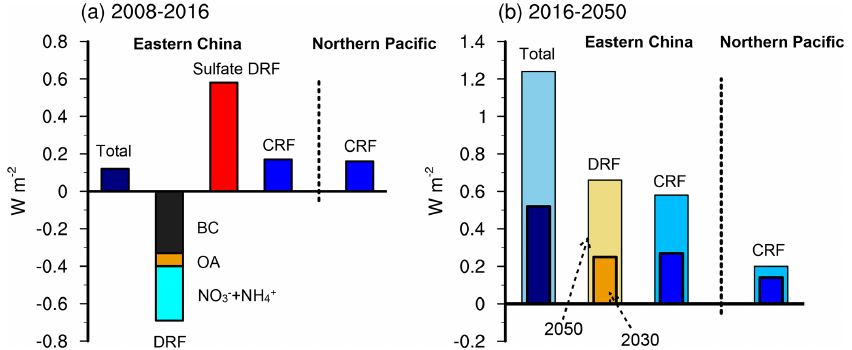
Figure 7. (a) The estimates of total RFs (aerosol DRF + CRF), DRF from major aerosol components due to aerosol–radiation interactions, and aerosol effects on clouds (CRF) over eastern China and the northern Pacific due to the changes in anthropogenic emissions between 2008 and 2016. (b) The estimates of aerosol DRF and CRF due to projected anthropogenic emissions for 2030 and 2050 relative to 2016. The aerosol DRF over the northern Pacific was negligible and not shown here. RFs: radiative forcings; DRF: direct radiative forcing; CRF: cloud radiative